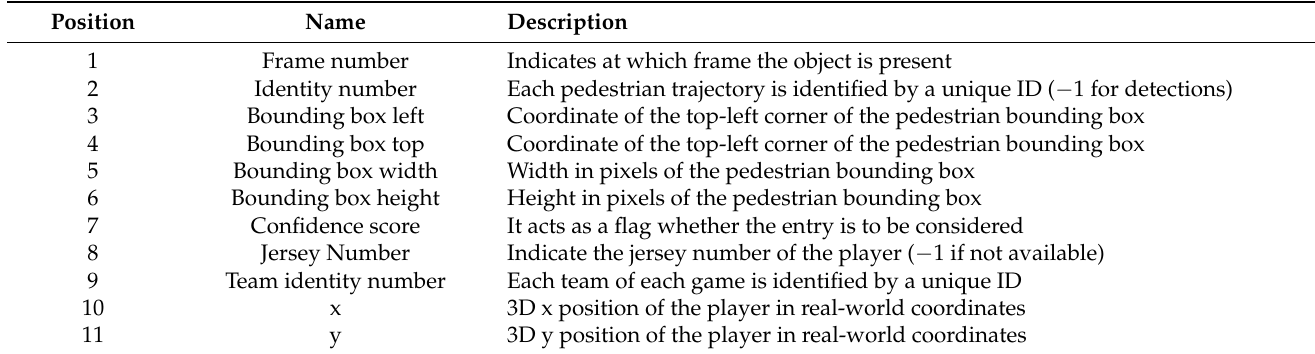
Table 3. Data Format of NPSPT Ground